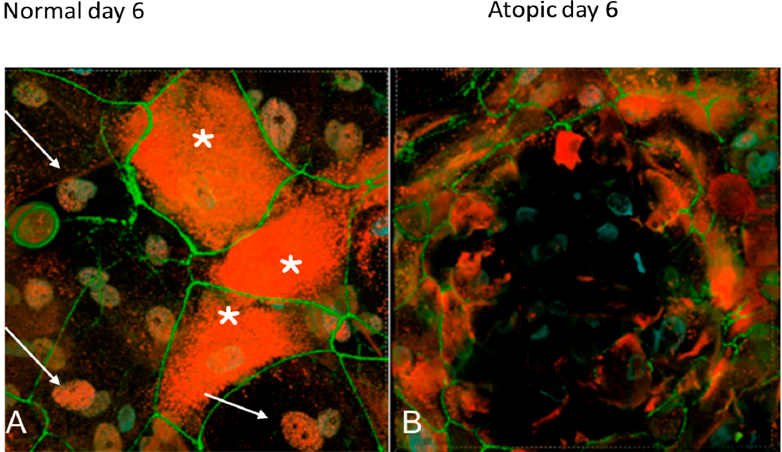
Figure 12. Confocal microscopy images of normal and atopic keratinocytes six days after confluence (D6). In normal keratinocytes ( A ), filaggrin (stained in red) is visible in the cytoplasm in some cells (white asterisks) and in the nucleus in others (white arrows). Atopic keratinocytes ( B ) have created little dome structures. ZO-1 (stained in green) was evident on the membrane in both normal and atopic keratinocytes. Light blue was DAPI, a fluorescent DNA stain, to locate the nucleus of the cells.